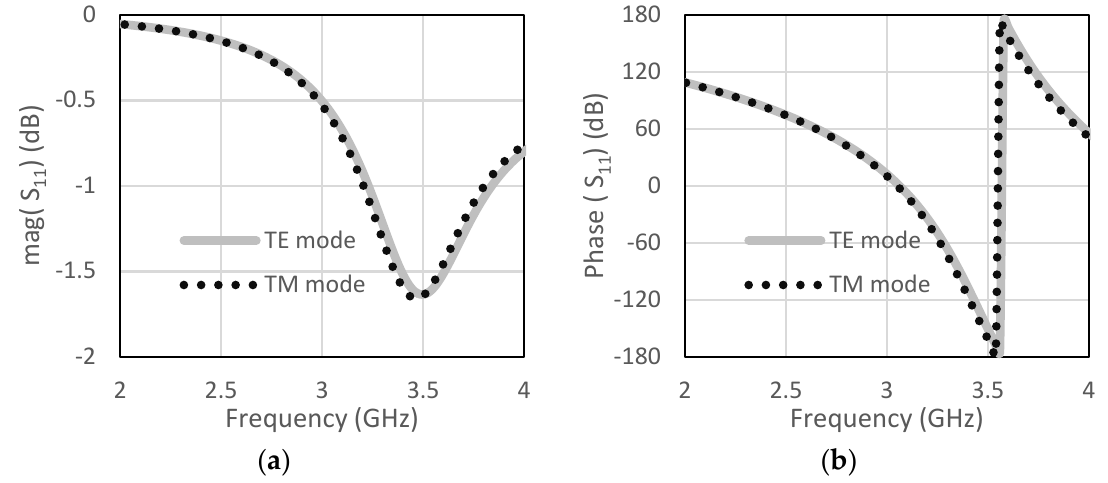
Figure 3. Circular patch with a ring ( a ) magnitude of S 11 ( b ) phase of S 11 .